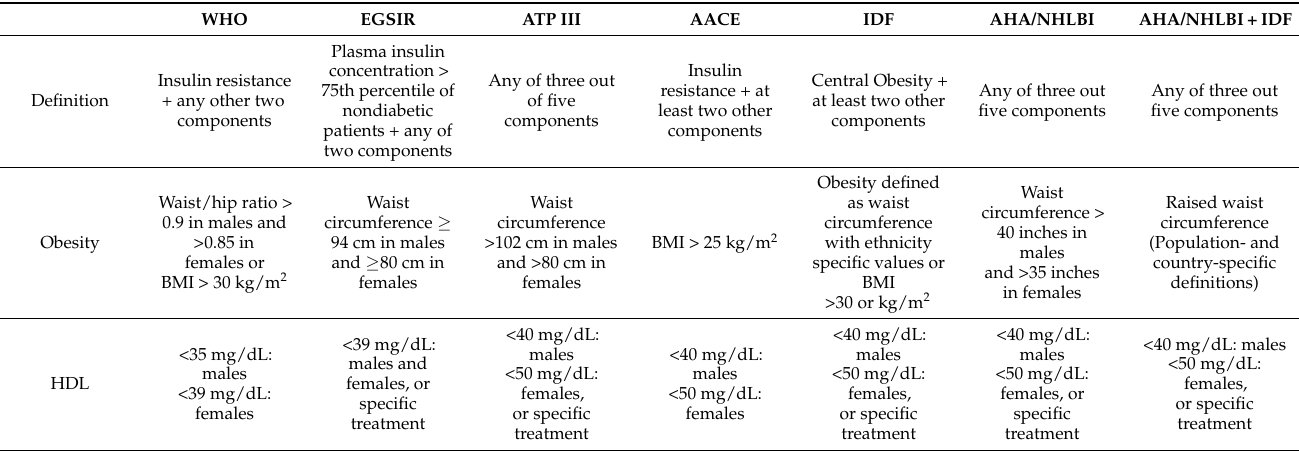
Table 1. Definition of Mets according to different scientific societies.